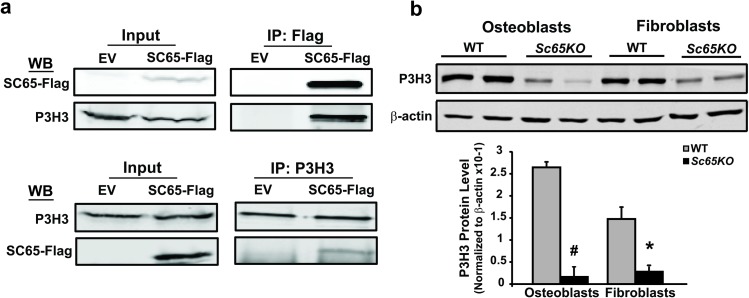
SC65 directly interacts with prolyl 3-hydroxylase 3 (P3H3).a) Lysates of 714 mouse embryonic fibroblasts stably expressing SC65-Flag or EV control were used for IP experiments utilizing a Flag antibody (upper panel) or a P3H3 antibody (lower panel). 10% of total inputs and immuno-precipitates were separated on a 10% SDS-PAGE gel, blotted and probed with antibodies against FLAG and P3H3. The reciprocal interaction of SC65-Flag with P3H3 is confirmed in both experiments. b) Western blot of primary calvarial osteoblast and skin fibroblast lysates from WT and Sc65KO 3 day-old mice (N = 2) showing significantly decreased levels of P3H3 protein in Sc65KO samples. Densitometric quantification of P3H3 protein normalized to β-actin from the western blot shown above (#p<0.01; *p<0.05; error bars represent SD). All experiments were performed at least 3 times.